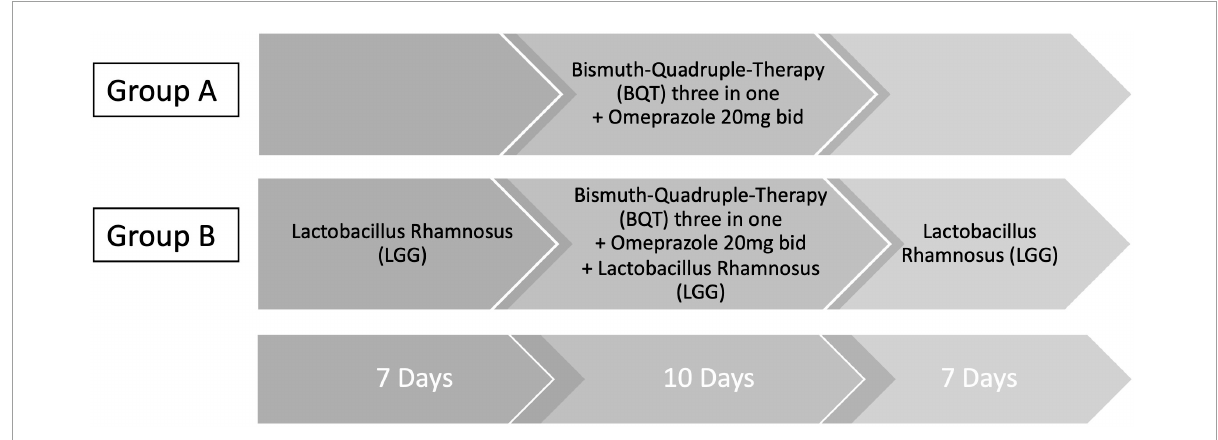
FIGURE1 Eradication therapy schedule. Three-in-one BQT therapy (140 mg bismuth subcitrate potassium/125 mg metronidazole/125 mg tetracycline hydrochloride) was given as follows: three capsules four times a day (qid) after main meals and before bedtime. Omeprazole was given 20 mg two times a day (bid) (before breakfast and before dinner). Group A received only three-in-one BQT qid plus omeprazole 20 mg bid for 10 days. Group B received three-in-one BQT qid plus omeprazole 20 mg bid for 10 days in combination with six million CFU (colony-forming units) of Lactobacillus rhamnosus (LGG), strain ATCC 53103. LGG was given for 24 days (7 days before BQT, 10 days during BQT, and 7 days after